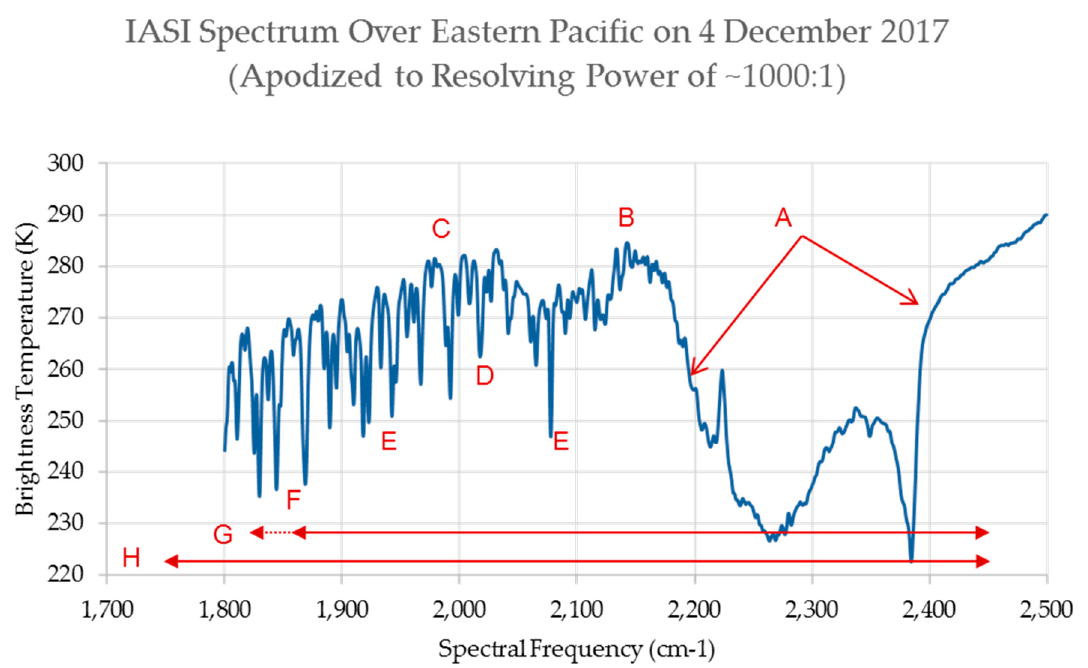
Figure 4. Spectral coverage range and resolution for MISTiC was selected to provide IR sounding of the troposphere. Key spectral regions are shown on this example spectrum from IASI, and described in the text. This spectrum that has been filtered so that the spectral feature shapes will be similar to those expected the MISTiC space instrument.